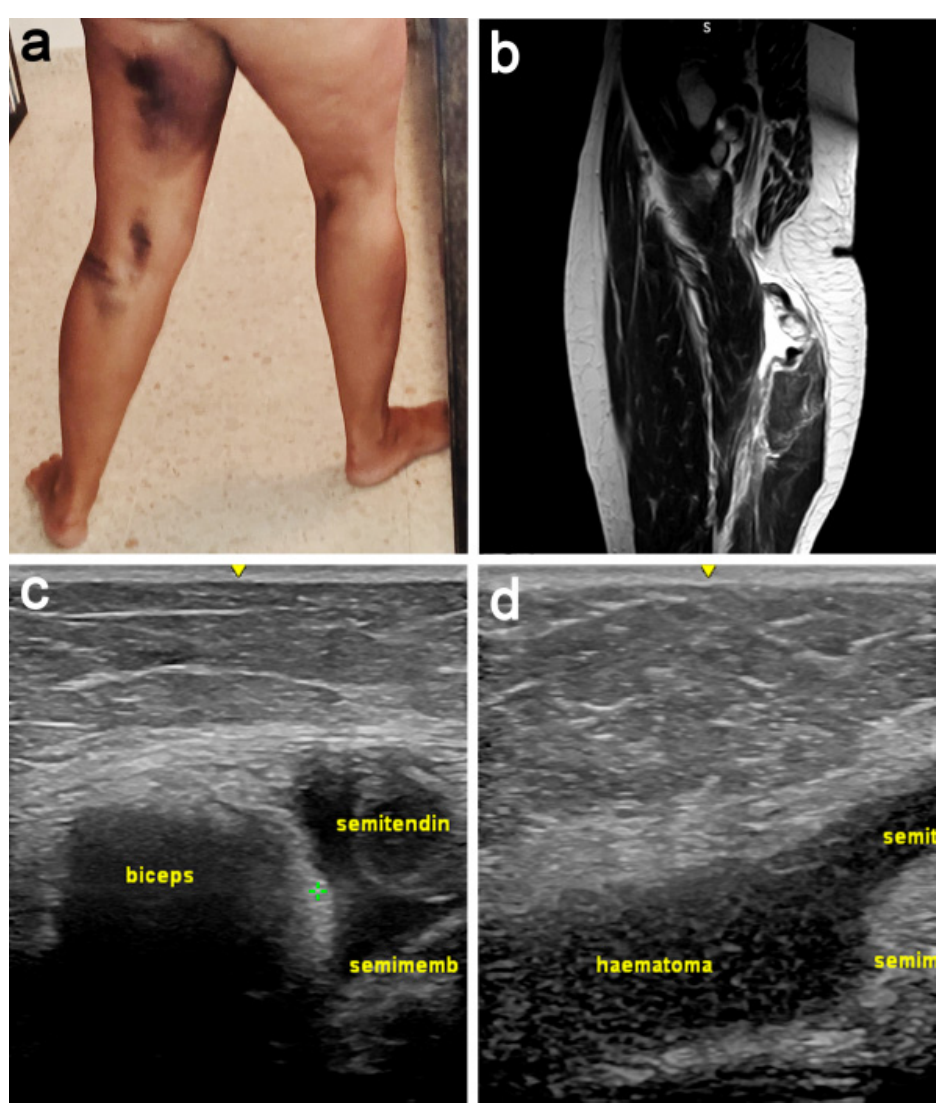
Figure 1. Preoperative description of the case. ( a ) Image of the haematoma two days after the accident, accompanied by lancinating pain with paresthesia similar to radicular pain. ( b ) MRI confirming the injury; the conjoint tendon was retracted 7 cm and the semimembranosus tendon 10 cm, with a significant accumulation of free fluid. ( c , d ) Ultrasound also showed complete disinsertion of both tendons, as well as their retraction.